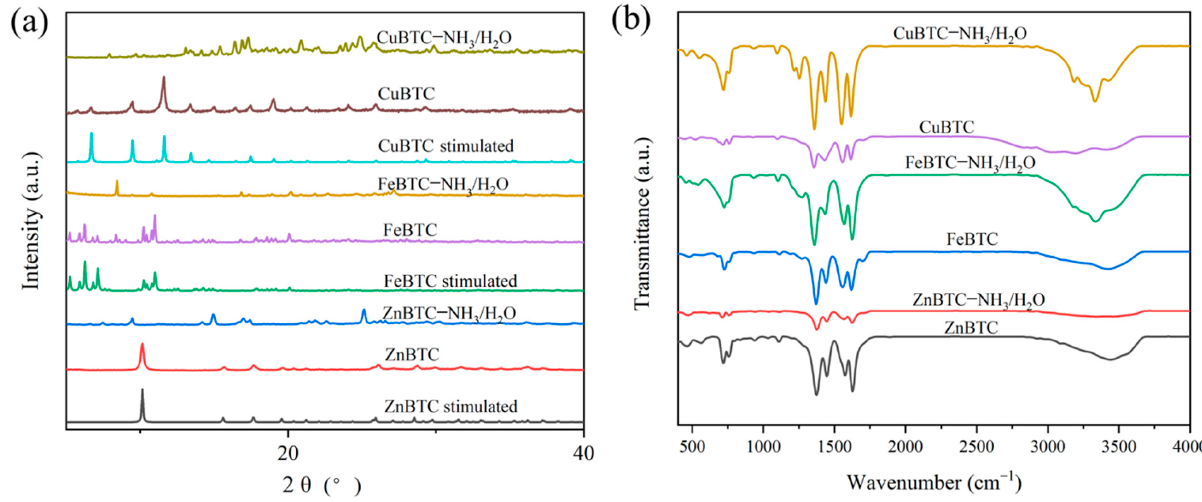
Figure 4. The XRD patterns ( a ) and FTIR ( b ) of ZnBTC, FeBTC and CuBTC before and after NH 3 adsorption.